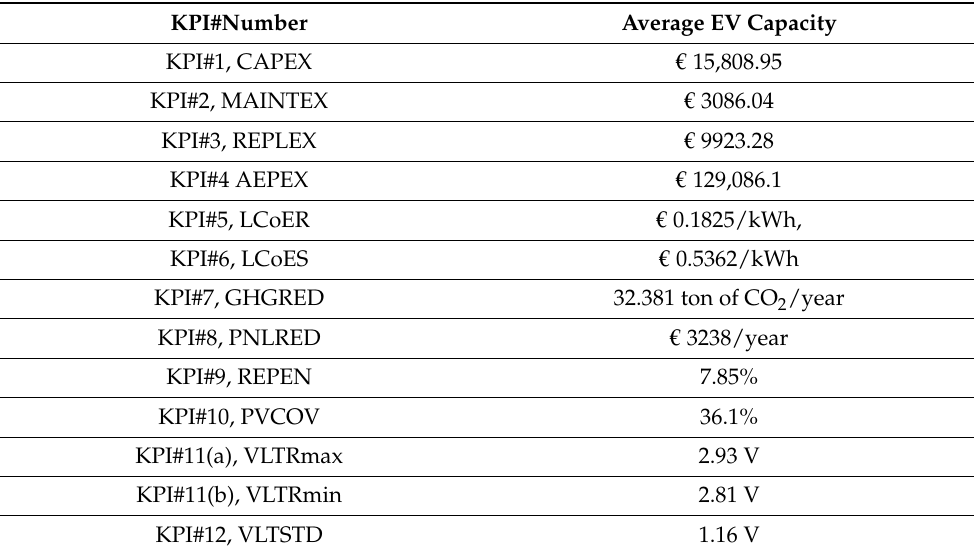
Table 3. KPIs evaluated for the MCAST